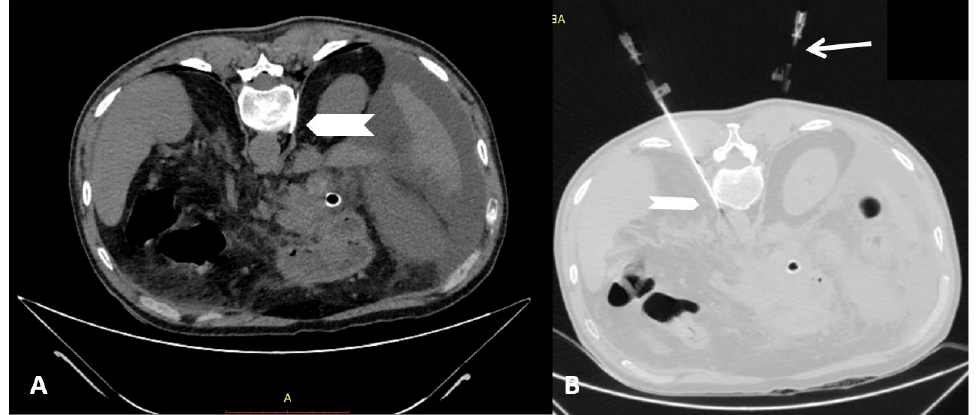
Figure 1. A 60-year-old, male patient with pancreatic ductal adenocarcinoma suffering from abdominal pain refractory to conservative medication was treated by CT-guided neurolysis of splachnic nerves by means of continuous radiofrequency. ( A ) Computed tomography axial scan (soft tissue window) illustrating the curved RF needle/electrode (white chevron) retrocrurally and anterolaterally to the T12 vertebral body on the right side. ( B ) Computed tomography axial scan (lung window) illustrating the curved RF needle/electrode (white chevron) retrocrurally and anterolaterally to the T12 vertebral body on the left side. Additionally, the vein catheters (white arrows) used for skin entrance of the blunt RF needle/electrode are illustrated as well.